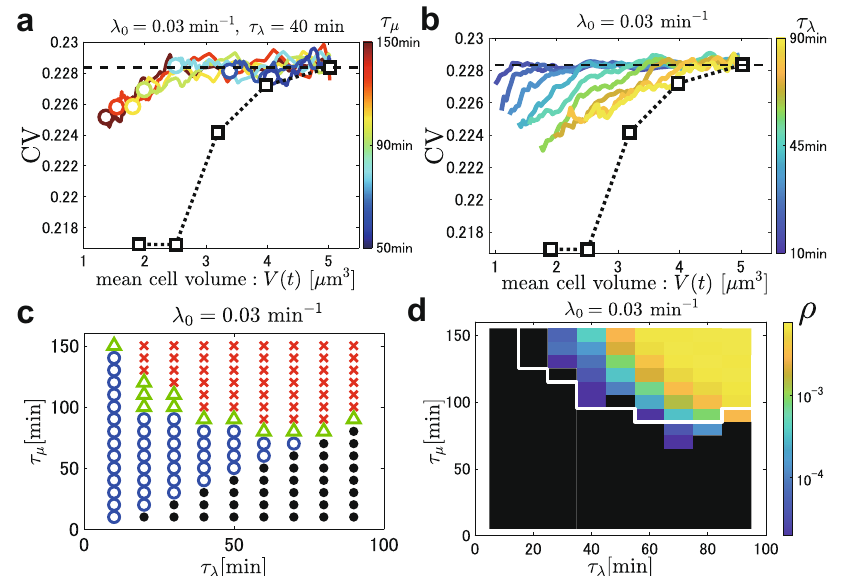
Fig. 5 Numerical results on the range of validity of the scale invariance. The initial growth rate is fi xed at λ ð 0 Þ ¼ λ 0 ¼ 0 : 03 min (cid:2) 1 unless otherwise stipulated. a Trajectories in the 〈 v 〉 – CV space for different τ μ (from 50 to 150 min), with τ λ ¼ 40 min fi xed. The endpoint of each trajectory is indicated by a colored open circle. The black squares represent the states in steady growth conditions with the growth rate λ 0 ranging from 0.01 to 0 : 03 min (cid:2) 1 . The dashed plateau indicates the initial CV at λ 0 ¼ 0 : 03 min (cid:2) 1 . b The master curves of the 〈 v 〉 -CV trajectories for different τ λ . Those are obtained by taking the average of the CV values at each 〈 v 〉 over different τ μ (> τ λ ). τ λ ranges from 10 to 90 min. c Phase diagram. ×: the scale invariance breaks down. Blue ○ : the scale invariance holds. Green △ : near the boundary. Black dots: the scale invariance holds but the mean volume increases. d Pseudocolor plot of ρ for different τ λ and τ μ . See the main text for the de fi nition of ρ . The black region indicates ρ = 0. The white line represents the transition line obtained from c . The boundaries ( △ ) are not included in the region where the scale invariance breaks